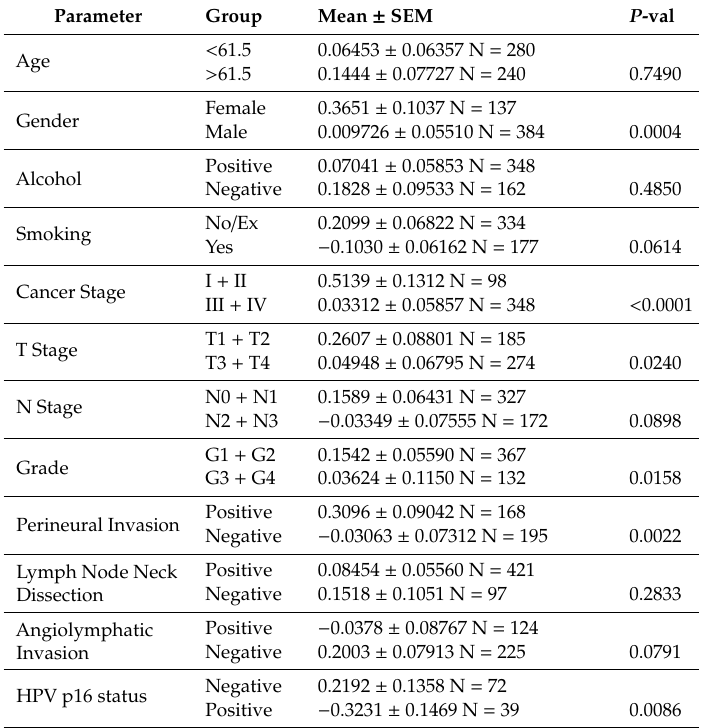
Table 3. The expression levels of ZNFX1 are dependent on clinicopathological parameters in all localizations of HNSCC. T-test; p < 0.05 considered as